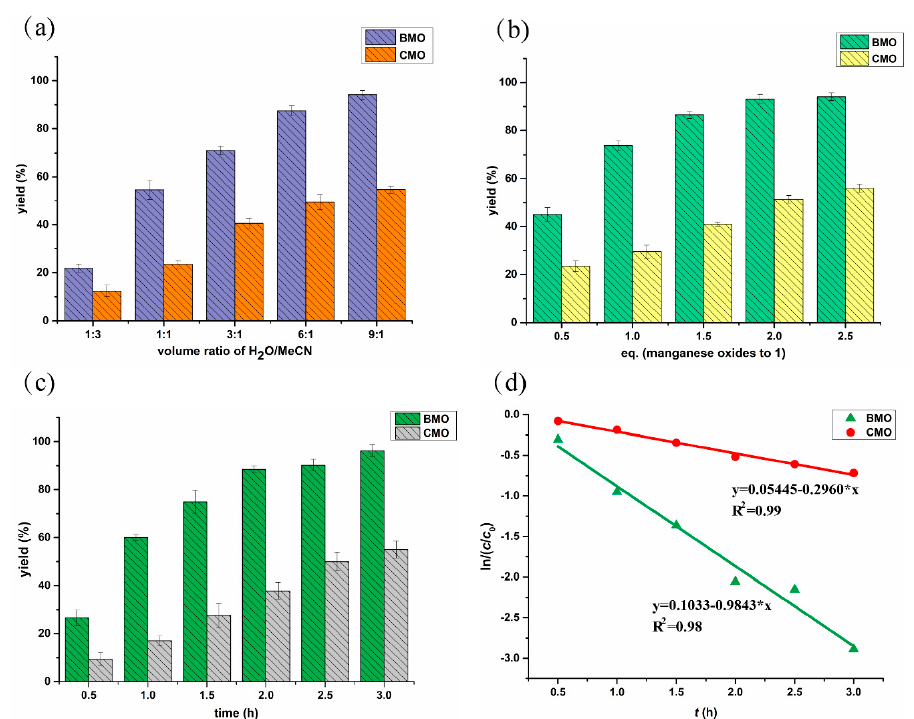
Figure 2. Comparing the synthesis of α‐ hydroxy ‐β‐ keto ester by the BMO (biogenic manganese oxides) from dry m ‐ MnB1 and CMO (chemical manganese oxides): ( a ) Effects of reaction media consisting of H 2 O/MeCN with different ratios; ( b ) Effects of dosage of BMO and CMO in H 2 O/MeCN (9:1); ( c ) Correlation of yield of 2 with time; ( d ) Pseudo ‐ first ‐ order plots of α‐ hydroxylation of β‐ keto Ester by BMO and CMO in the first 3 h.